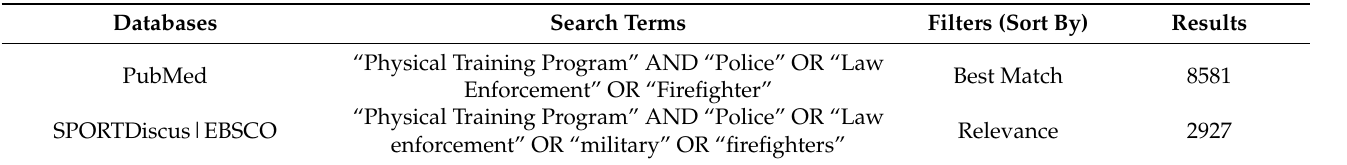
Table 1. Databases and relevant search